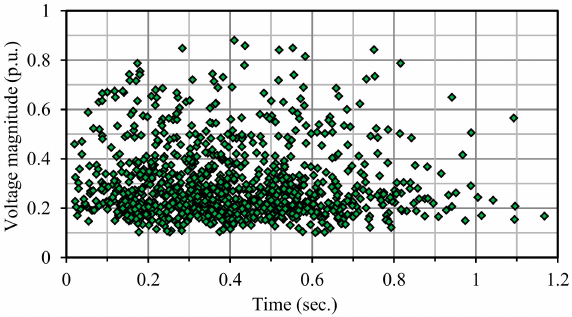
Figure 12. SSD associated with the network under study.